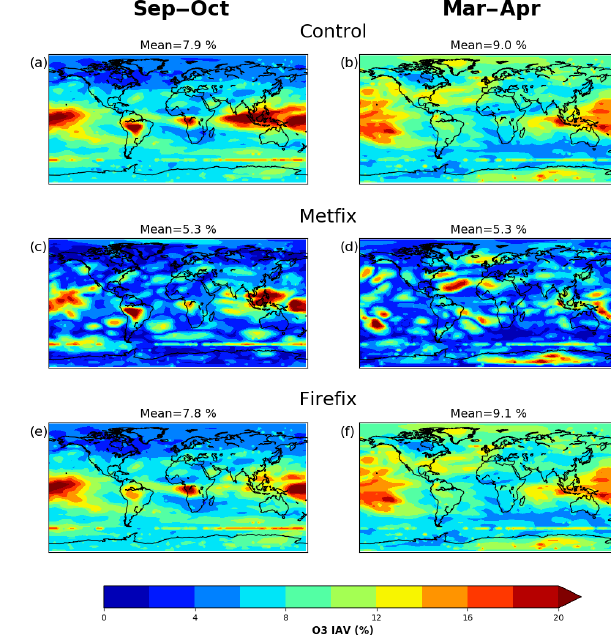
Figure 6. The calculated interannual variability (coefficient of variation) of ozone over the period 1997–2014 for September– October (a, c, e) and March–April (a, c, e) from (a, b) the con- trol simulation (CTRL), (c, d) fixed meteorology (METFIX) and (e, f) fixed fire emissions